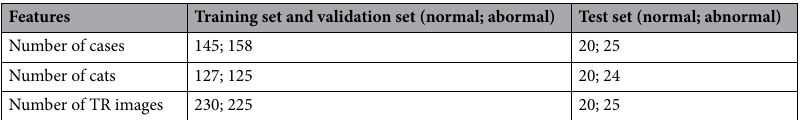
Table 1. Features of the database used in the study. Number of cases a case is defined as a veterinary visit, thus distinct cases could come from a unique cat. Number of cats represents the number of cats enrolled in the study. Number of TR images represents the number of TR images composing the